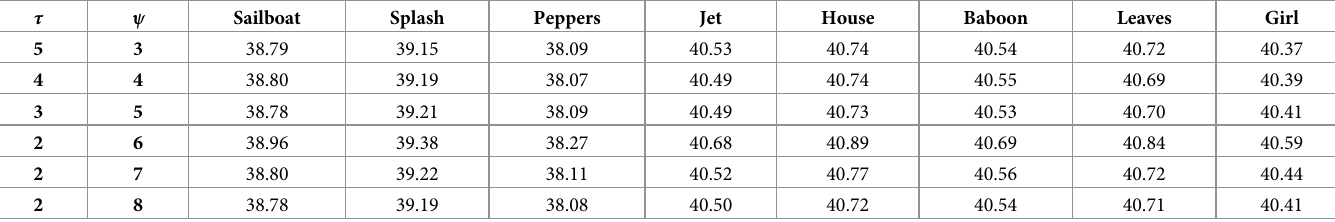
Table 2. PSNR comparisons of fully embedded